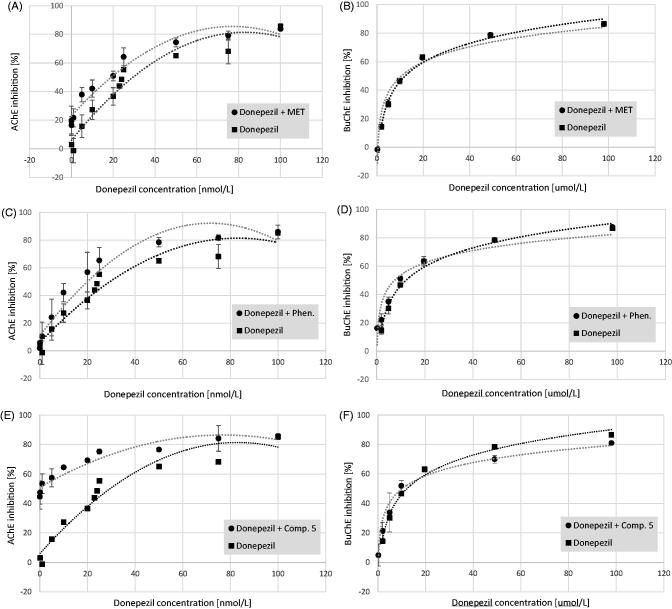
The effects of donepezil and binary mixtures of tested compounds on the activity of cholinesterases expressed as % of enzyme inhibition. (A) Acetylcholinesterase (AChE) inhibition by donepezil (0.01–100 nmol/L) and a mixture of donepezil and metformin at a concentration of 600.0 µmol/L. (B) Butyrylcholinesterase (BuChE) inhibition by donepezil (0.01–100 µmol/L) and a mixture of donepezil and metformin at a concentration of 600.0 µmol/L. (C) Acetylcholinesterase (AChE) inhibition by donepezil (0.01–100 nmol/L) and a mixture of donepezil and phenformin at a concentration of 600.0 µmol/L. (D) Butyrylcholinesterase (BuChE) inhibition by donepezil (0.01–100 µmol/L) and a mixture of donepezil and phenformin at a concentration of 150.0 µmol/L. (E) Acetylcholinesterase (AChE) inhibition by donepezil (0.01–100 nmol/L) and a mixture of donepezil and compound 5 at a concentration of 150.0 µmol/L. (F) Butyrylcholinesterase (BuChE) inhibition by donepezil (0.01–100 µmol/L) and a mixture of donepezil and compound 5 at a concentration of 300.0 µmol/L. Each data point shows the mean ± SD for three independent experiments conducted in duplicates. Dotted trend lines represent the average of three independent experiments. Quadratic and logarithmic equations from each conducted experiment allowed to determine the IC50 value for the mixtures.